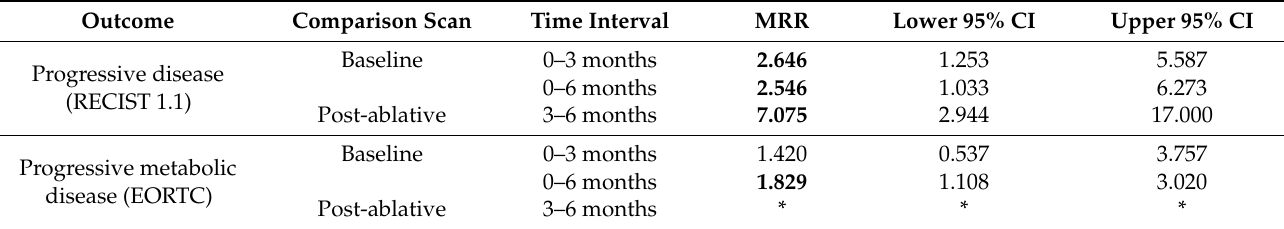
Statistically significant results in bold. * Results not shown because all patients were categorized as progressors; MRR, mortality rate ratio; CI, confidence interval; CT, computed tomography; PET, positron emission tomography; RECIST 1.1, Response Evaluation Criteria in Solid Tumors version 1.1; EORTC, European Organization for Research and Treatment of Cancer PET response